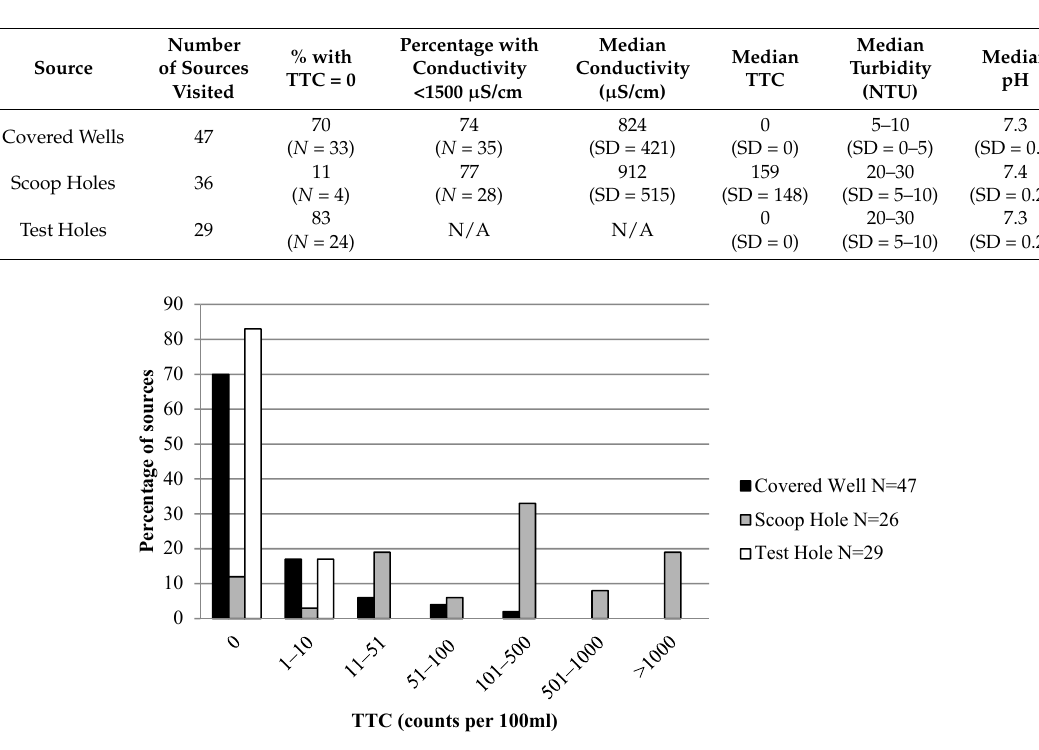
Table 2. The water quality information from sand dam abstraction points.